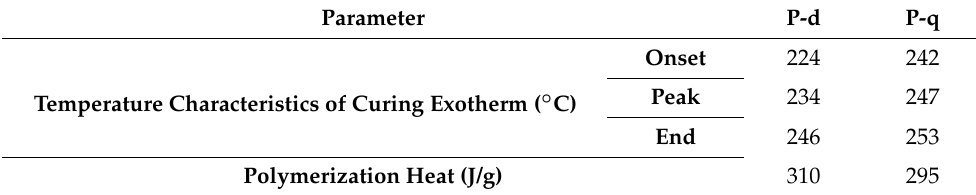
Table 4. Differential scanning calorimetry